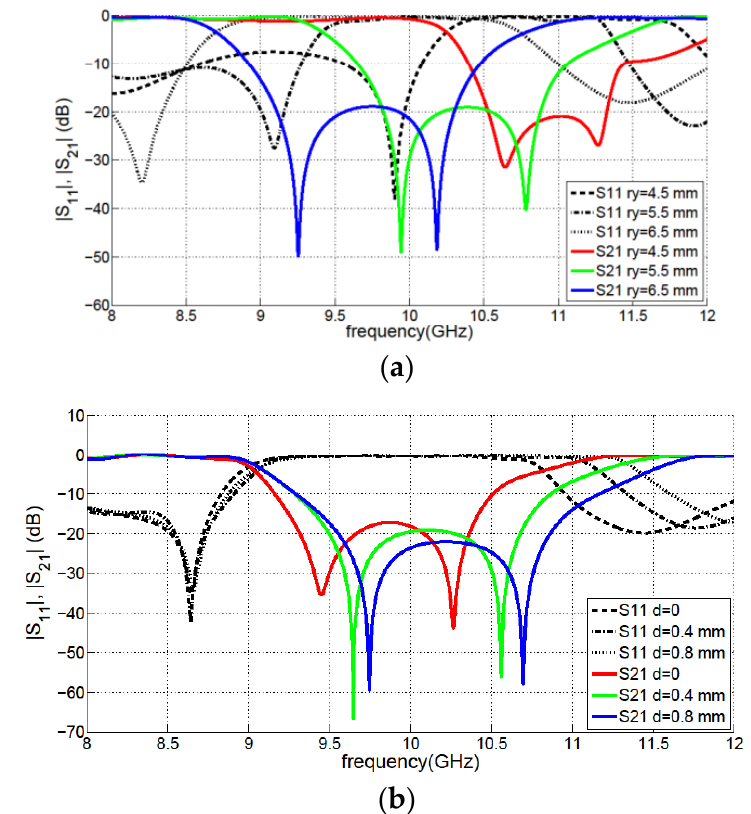
Figure 11. Simulated S21 response for the 3-cell filter (rx = 5mm, r = 0.75 mm, gx = 0.2 mm and gy = 2.5 mm) varying: ( a ) coupling length (ry) ( b ) via position distance (d) from the edge of the resonator patch.